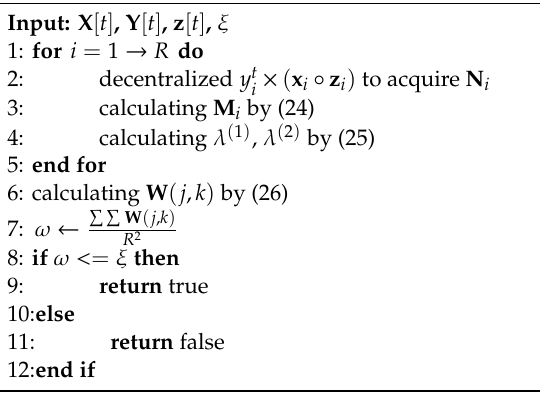
Algorithm 2 CP Rank estimation via multilinear